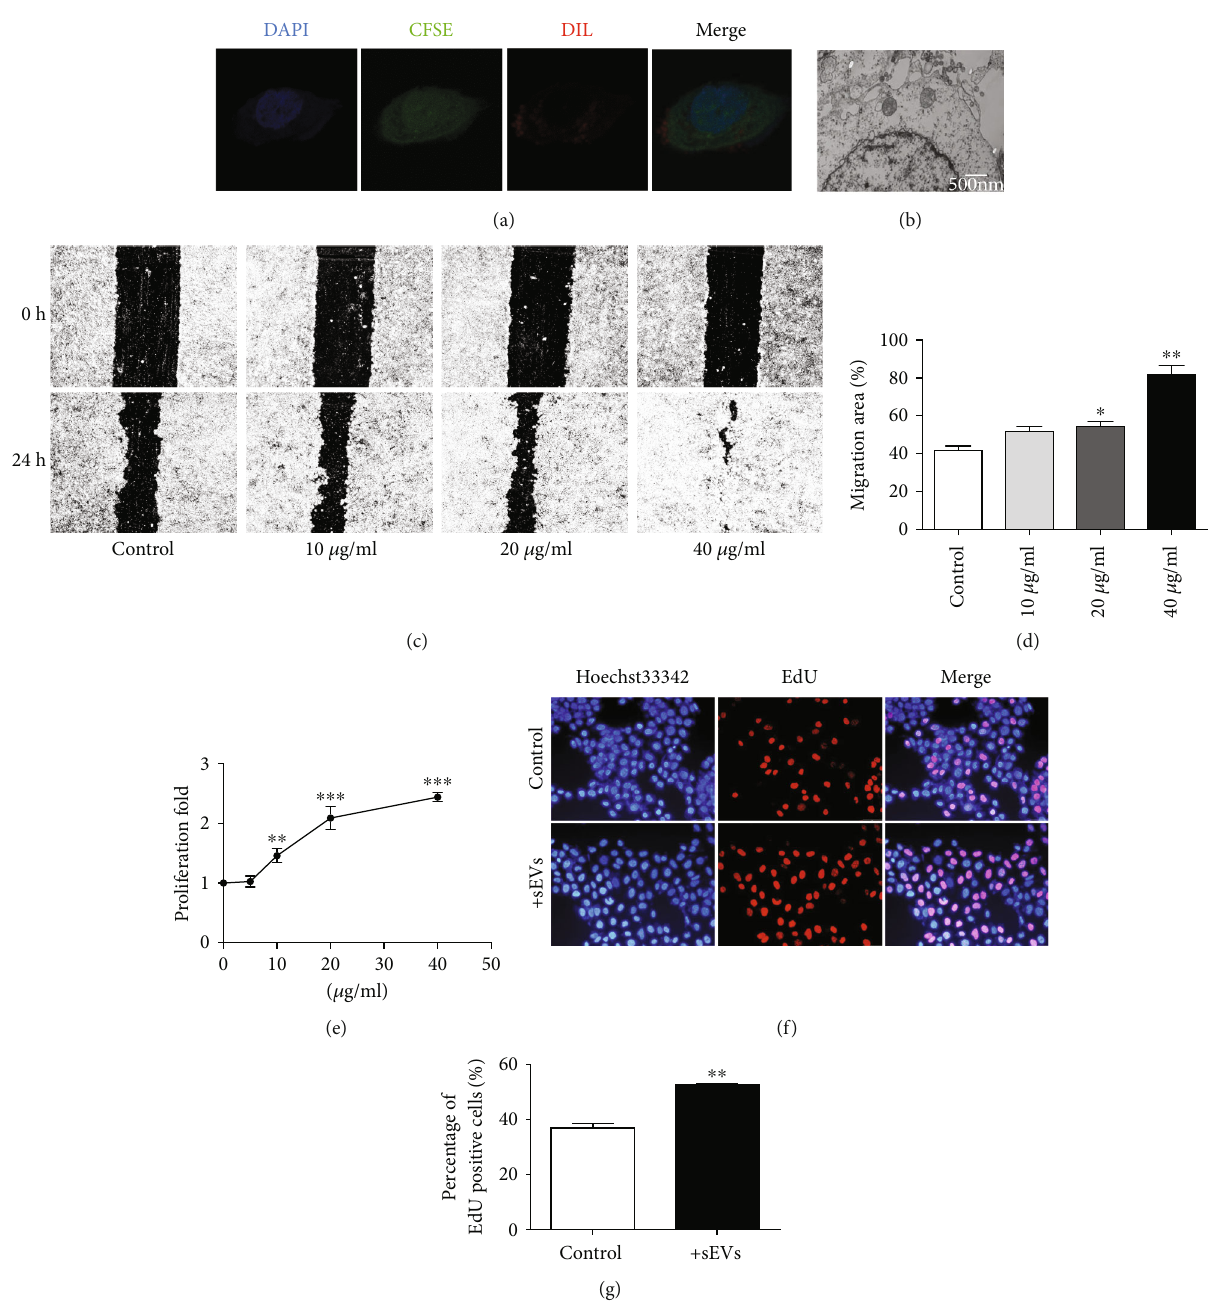
Figure 3: The e ff ect of HUMSC-sEVs on HCECs ’ proliferation and migration in vitro. (a) Fluorescence images of CFSE-labeled HCECs (green) incubated with Dil-labeled HUMSC-sEVs (red). Nuclei were stained with DAPI (blue). (b) TEM of HCECs incubated with HUMSC-sEVs. (c, d) Representative images from in vitro scratch wound healing assays demonstrating that cell migrates into the cell- free region is signi fi cantly promoted in the presence of HUMSC-sEVs when compared to controls, n = 4 . (e) CCK-8 assay showed increased proliferation of HCECs incubated with HUMSC-sEVs after 48 hours, n = 5 . (f, g) The proliferating HCECs were detected by EdU incorporation. The cells were treated with HUMSC-sEVs or blank control, n = 3 . Blue: nuclear staining (Hoechst33342); red: EdU staining. Data are expressed as the means ± SD . ∗ P < 0 : 05 , ∗∗ P < 0 : 01 , and ∗∗∗ P < 0 : 001